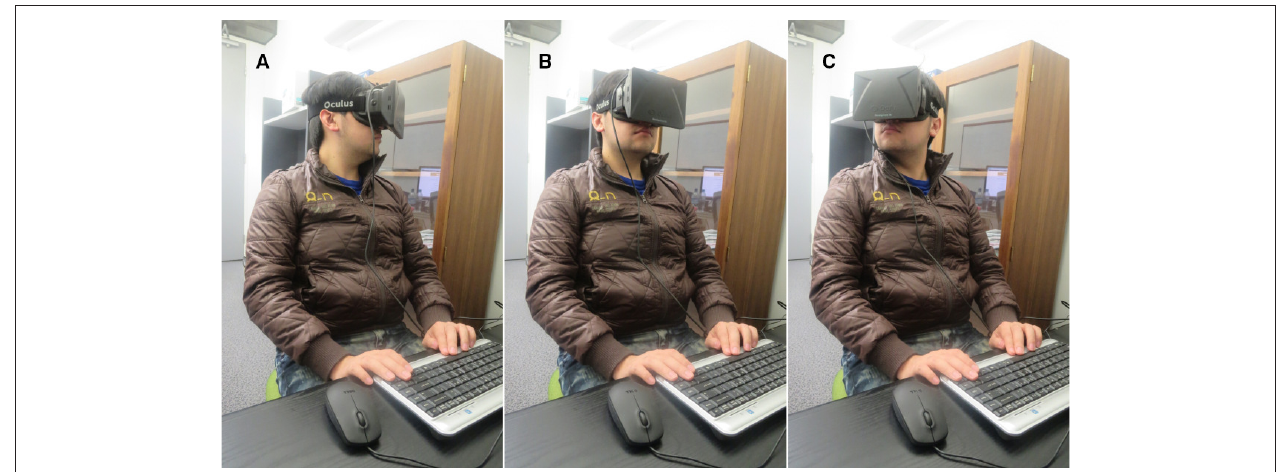
passive conditions, the observer sat still with their head in a constant forward orientation in yaw (B) . A keyboard within arm’s reach provided a comfortable interface for the observer to make psychophysical